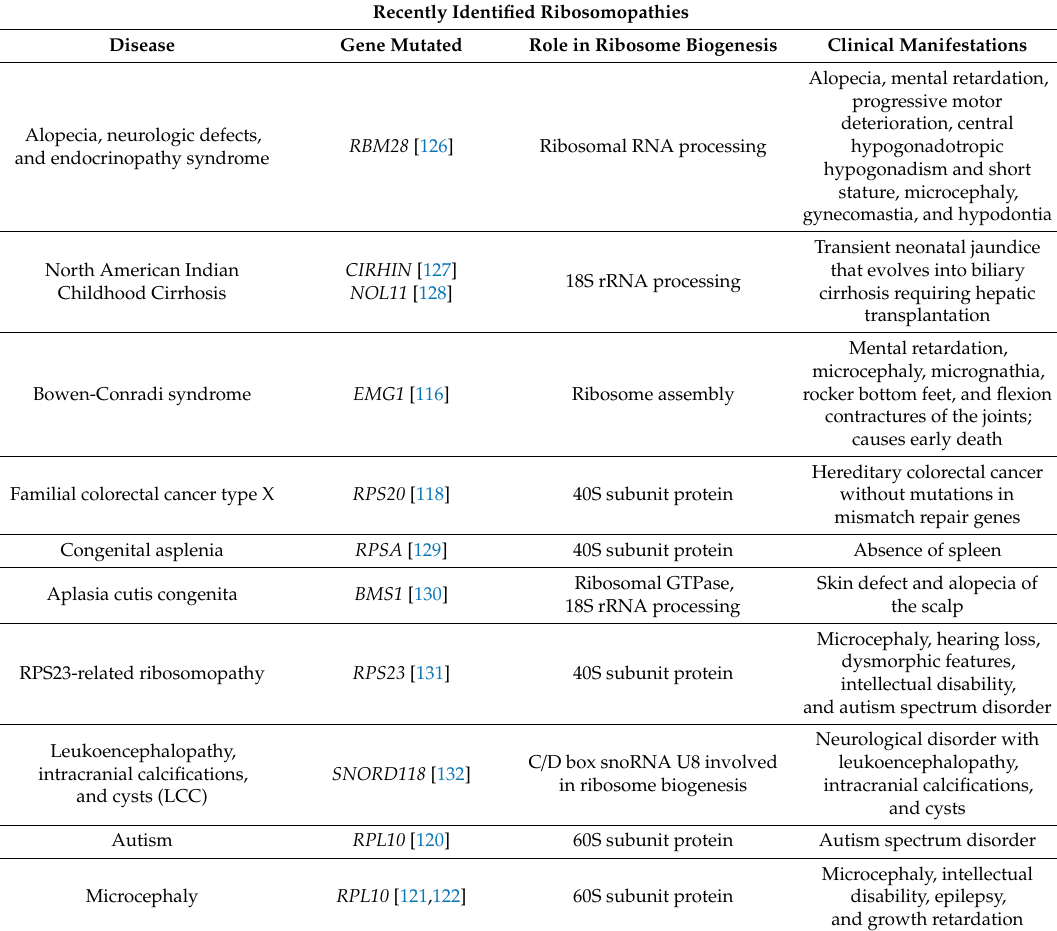
Table 2. Recently identified